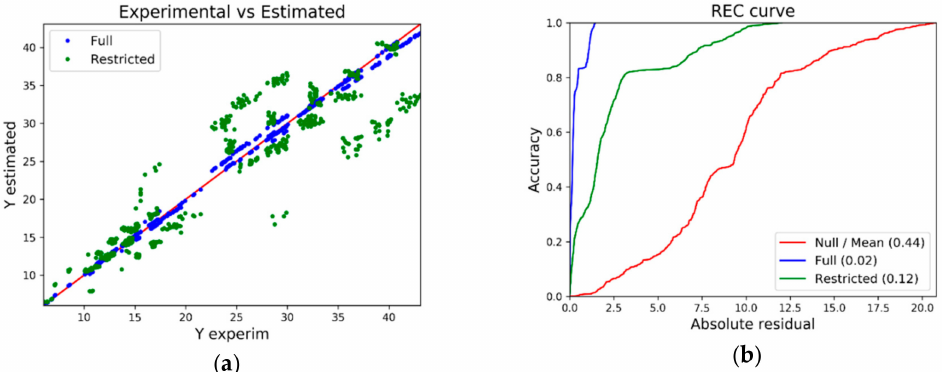
Figure 13. Results of the heating load (reduced variable set) problem for the full and restricted models with the parameter selection h = ω = 0.04. ( a ) Estimated vs experimental values; ( b ) REC curve for the full, restricted, and null (mean)